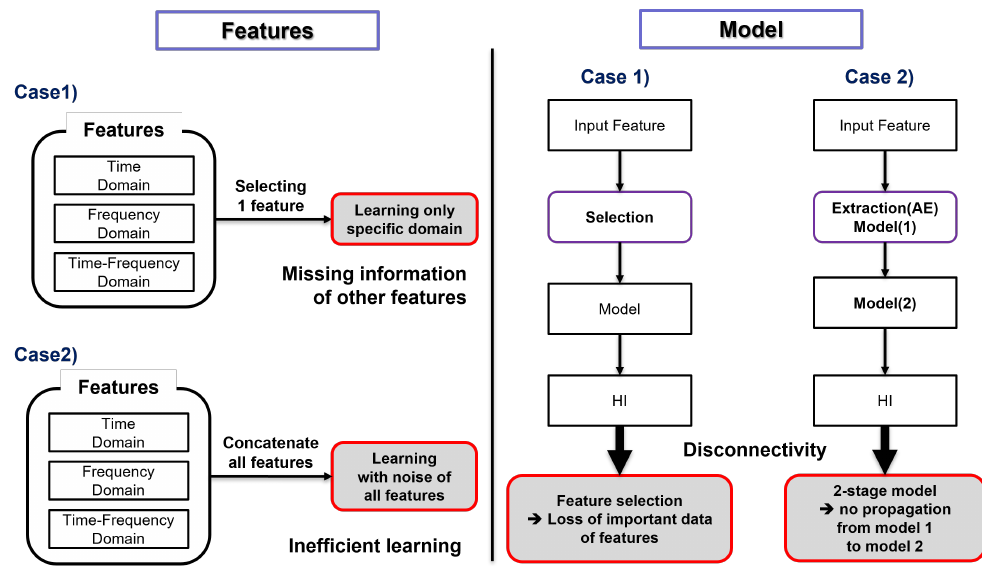
Figure 1. Disadvantages of legacy preprocessing and learning models: (Features) Case 1 is feature selection, while Case 2 is feature concatenation. (Model) Case 1 is feature selection with learning the health indicator. Case 2 is 2-stage learning after feature